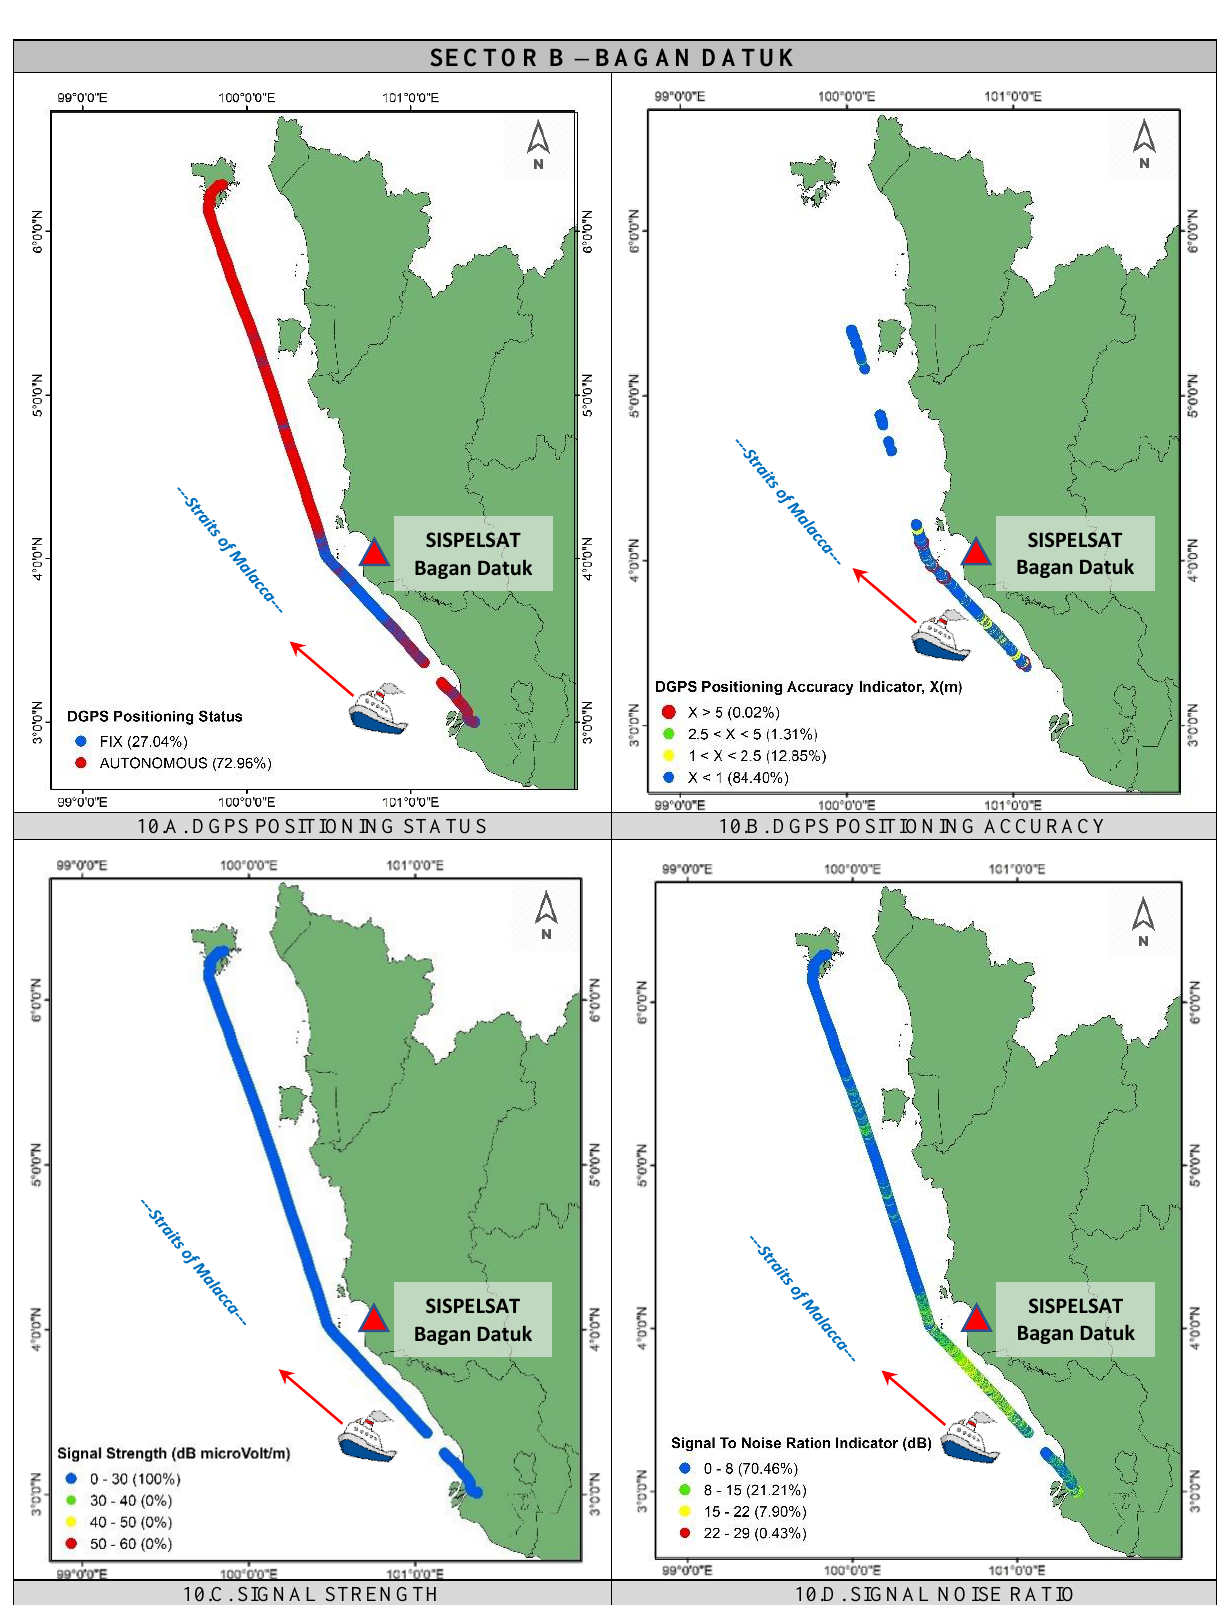
Figure 10. Result map of sector B – SISPELSAT Bagan Datuk